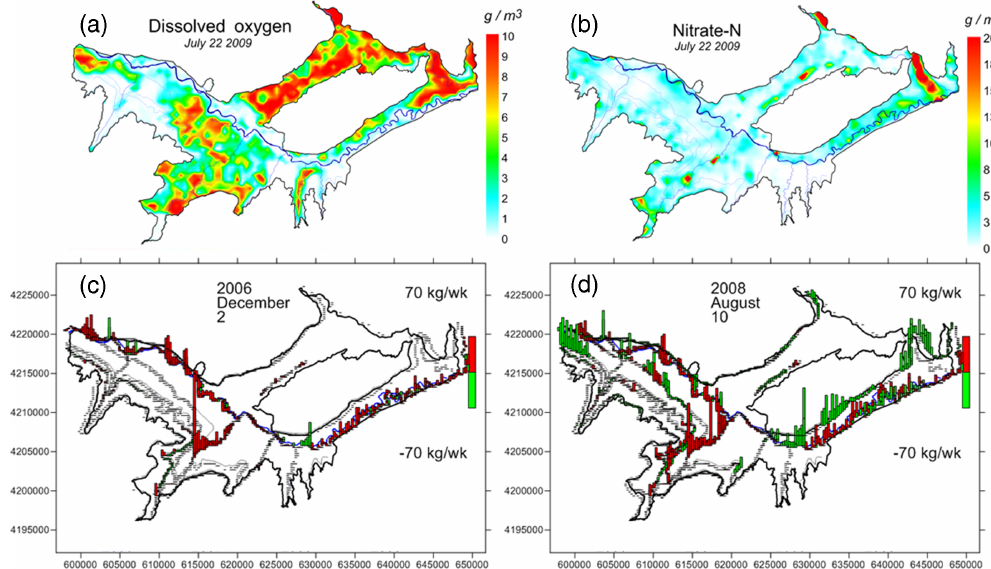
Figure 6. Summary of typical UZF-RT3D model results for the study region, showing spatial distribution of (a) C O shallow groundwater, and spatial distribution of mass loadings of nitrate to the Arkansas River system (main stem and tributaries) for (c) 2 December 2006, and (d) 10 August 2008, showing the contrast between the winter and summer seasons.